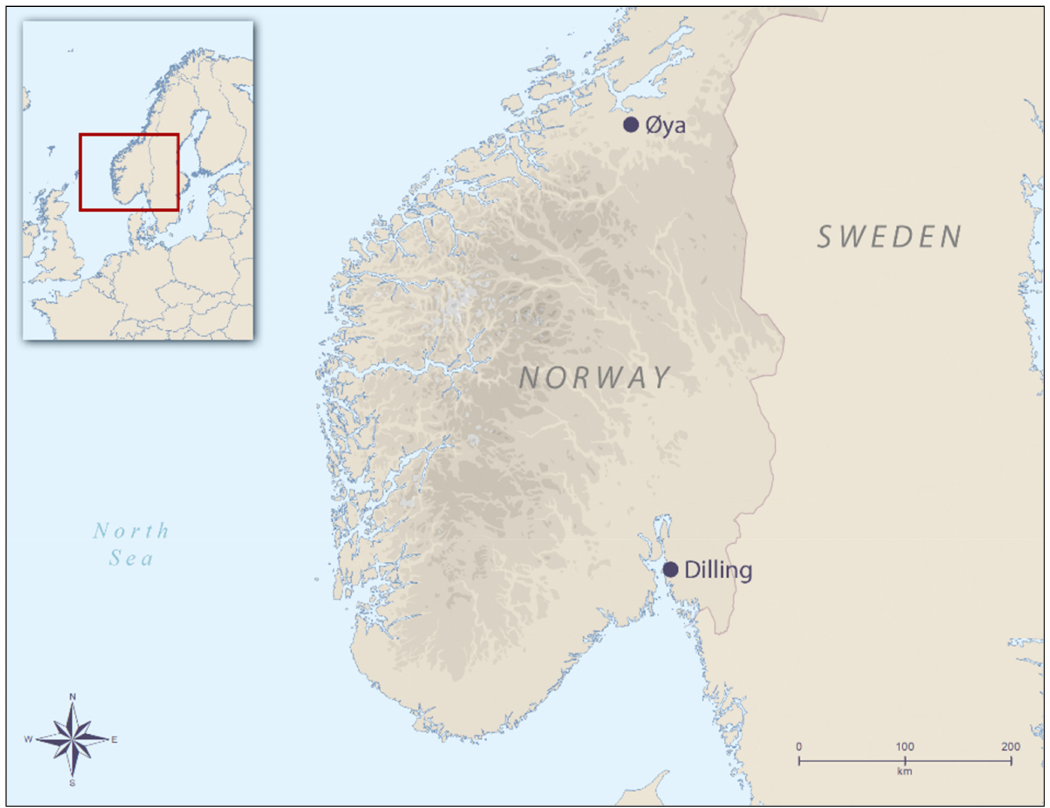
Figure 3. General map of central and southern Norway, showing the location of the two case study areas. Map source: The Norwegian Mapping Authority, Geovekst and Municipalities,